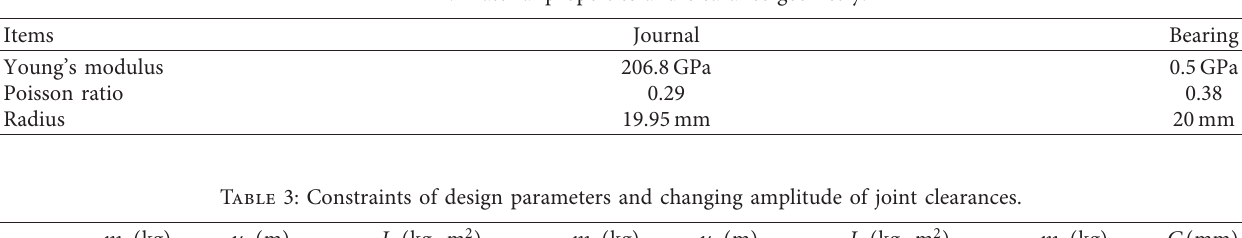
Table 2: Material properties and clearance geometry.